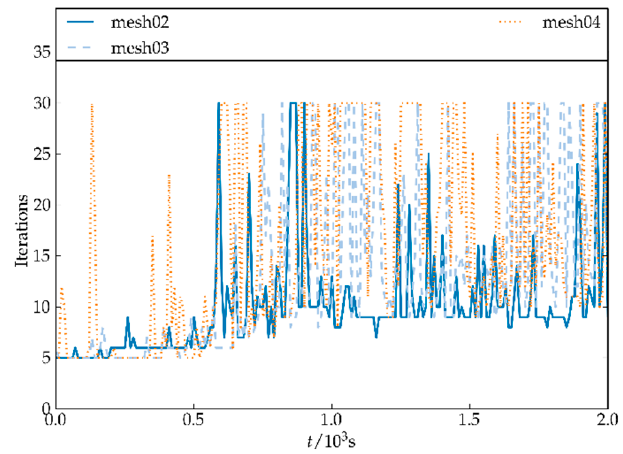
Figure 8. Iterations needed per time step during impact.